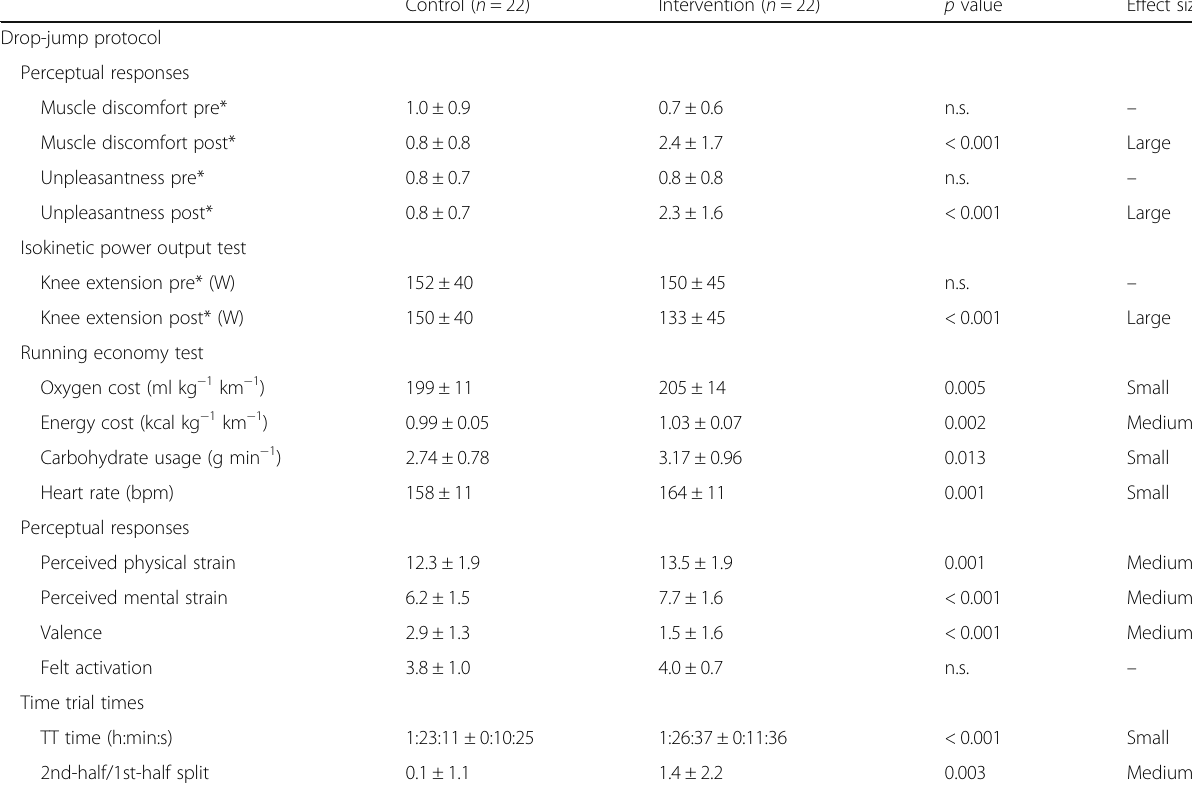
Table 2 Responses to drop-jump protocol and impact on power output, running economy, and time trial performance